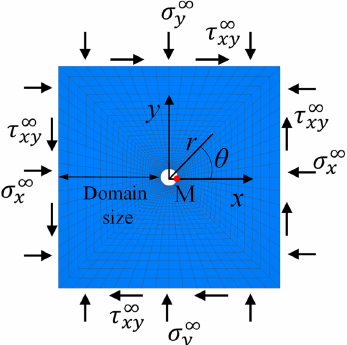
Figure A2. Plane strain numerical model of a cylinder hole in an infinite linearly elastic material built with FLAC 3D . The numerical results of radial displacement and tangential stress are obtained at point M in Figure A2. Figure A3 shows the variations of radial displacement and tangen ‐ tial stress at point M as functions of the domain size. The variation of numerical results reduces as the domain size increases from 1 to 20 m, and become stable when the domain size is larger than 10 m. Therefore, the optimal domain size is determined as 12 m that is 6 times the size of the hole.